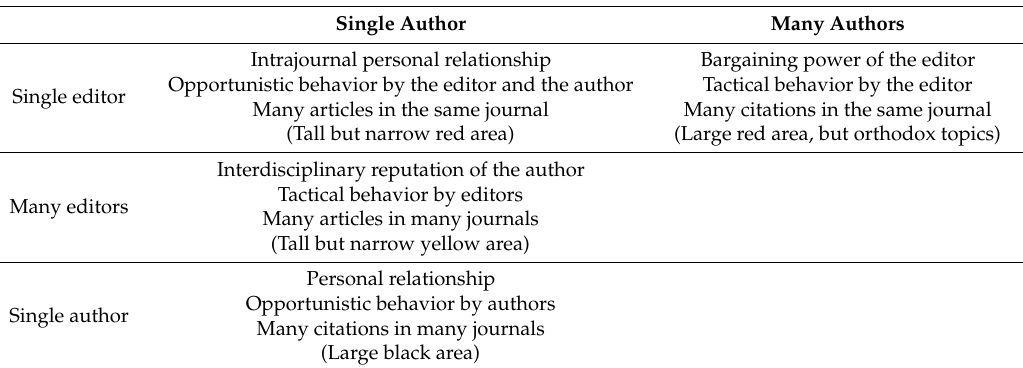
Table 4. Summary of potentially questionable practices by editors and authors: sources, behavior types, observations, and warning